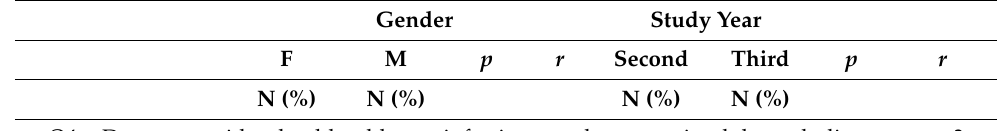
Table 1. Assessing the perception of the knowledge level on the modes of infection transmission. Comparative data and Chi-square